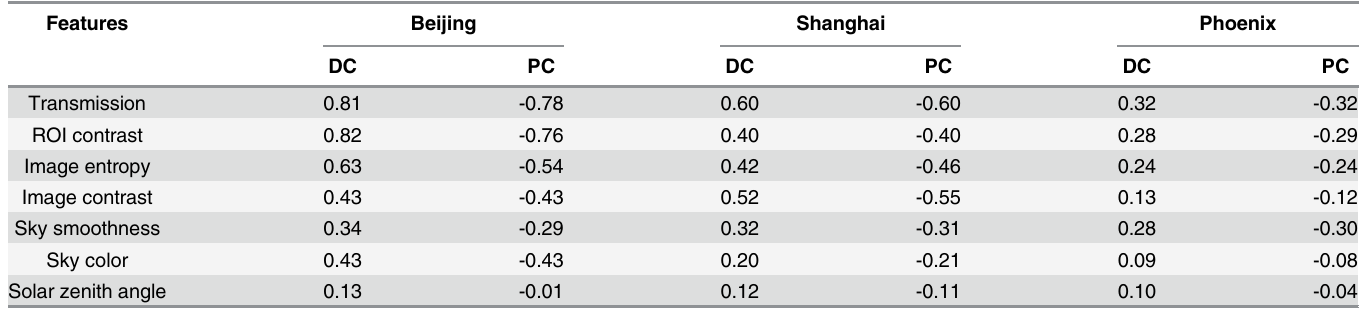
To evaluate the features used in the current method, we calculated the distance correlation index. The dis- (DC) and Pearson correlation (PC) between each extracted feature and PM 2.5 tance correlation is a measurement of dependence between random vectors. DC varies between index. 0 and 1, representing low and high correlation between an extracted feature and PM 2.5 PC is a measure of linear relationship between two vectors, which varies from -1, indicating a perfect negative linear relationship, to 1, indicating a perfect positive linear relationship. index, As shown in Table 4, the transmission has one of the largest correlations with PM 2.5 which is an important indicator of PM concentration. The ROI contrast, whole image contrast index, supporting human visual and image entropy also show good correlations with PM 2.5 index. The sky smoothness and perception that the visibility decreases with increasing PM 2.5 index. As for solar zenith angle, the DC and color analysis have some correlations with PM 2.5 index. The statistical PC values are low, indicating little correlation of the quantity with PM 2.5 analysis shows that transmission, image contrast and sky features are good features for PM 2.5 estimation. We also calculated the PC between solar angle and other features. The DC and PC between solar zenith angle and sky smoothness are 0.38 and 0.22 respectively, and the DC and PC between solar zenith angle and sky color are 0.24 and 0.23 respectively. The solar angle shows correlations with sky smoothness and color. The normalization of the related image fea- tures with the solar zenith angle could improve the prediction accuracy. In this study, two feature optimization methods were used to evaluate the feature redun- dancy and achieve the optimized regression performance. The first one is principle component analysis (PCA) [31]. The second one is sequential backward feature selection (SBFS) [32], and the criterion is RMSE. All eight features were included in the datasets: transmission, ROI con- trast, image entropy, image contrast, sky smoothness, sky color, solar zenith angle and relative humidity. We used PCA on the datasets to reduce the dimensions, and then perform the train- ing and regression with 1~7 principle components (PC) respectively. The PCA-SVR results are shown in Fig 10. Compared with the previous results, the regression error in Beijing ’ s dataset (RMSE: 39.08, R squared: 0.69) is smaller using the first 5 PCs. For Shanghai ’ s dataset, the Table 4. The features and their correlations with PM 2.5 index in our dataset. Features